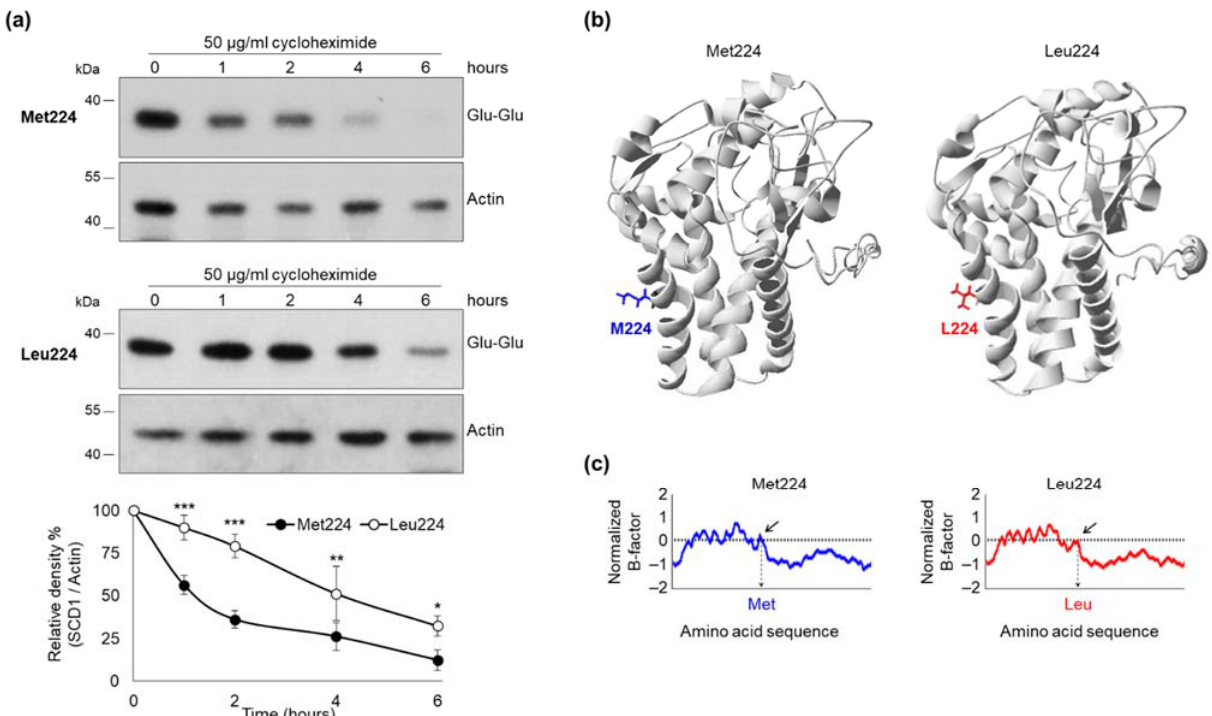
Figure 3. Intracellular degradation of M224L variants. ( a ) HEK293T cells were transiently transfected with Glu-Glu tagged Met224 and Leu224 expressing constructs. 24 h after transfection cells were treated with cycloheximide (50 mg/mL) for 0, 1, 2, 4, and 6 h. Western blot analysis of cell lysates (2 µg protein per lane) was carried out using anti-Glu-Glu tag and anti-Actin antibodies. Representative result of four independent experiments is shown. Data are shown as mean values ± S.D. The band intensities were quantitated by densitometry and SCD1-Glu-Glu/Actin ratios are shown as bar graphs. Statistical analysis was performed with the Tukey–Kramer Multiple Comparisons Test. Data are shown as mean values ± S.D. * p < 0.05; ** p < 0.01; *** p < 0.001. ( b ) Resolved crystal structure of Met224 human SCD1 was obtained from Protein Data Bank (file 4ZYO). 3D structure of Leu224 polymorphic variant was predicted by I-TASSER. Images were rendered using DeepView/Swiss-Pdb Viewer version 4.0.2. Met224 is shown in blue, Leu224 is shown in red. ( c ) Comparison of normalized B-factor values for Met224 and Leu224 SCD1 variants. The normalized-B factor (B-factor of each residue/B-factor of whole average) was plotted as the function of the amino acid residues. The blue line indicates the Met224 protein, and the red line shows Leu224. The position of the polymorphic residue change is indicated on the horizontal axis.